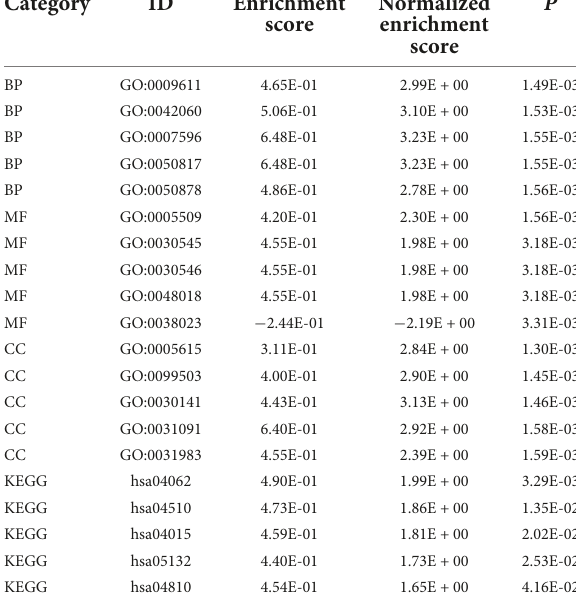
TABLE 2 Top five terms in